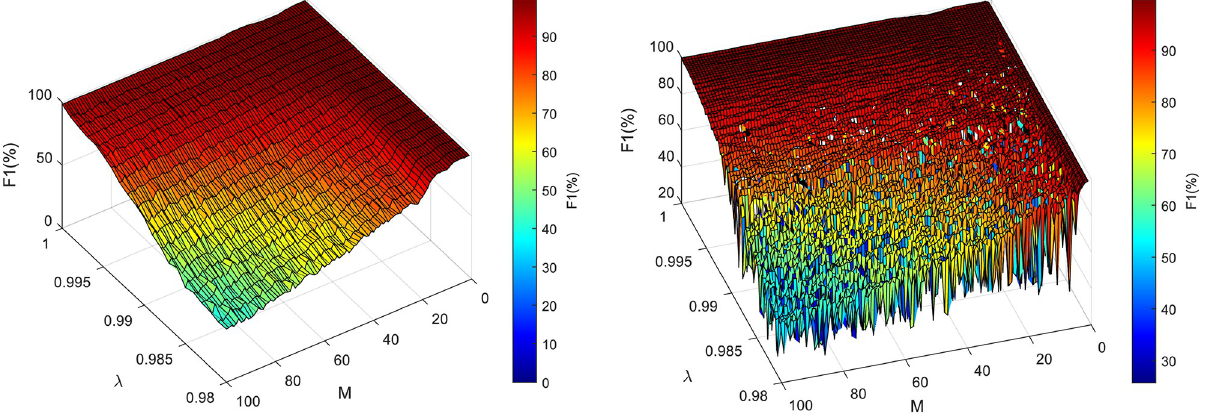
Fig 6. Comparison of the results of FTF-based systems for recording r01, λ 2 (0.9, 1), M 2 (0, 100). From left to right: a) System using Standard RLS algorithm; b) System using FTF algorithm.